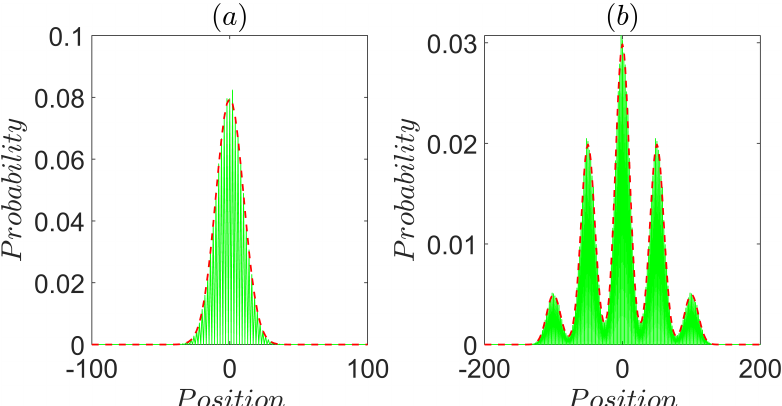
Figure 1. The simulated probability distributions of the one-dimensional Hadamard walk un- der the decoherence Model 1 for 100 time steps: ( a ) The walker is initiated from the local- ( | 0 (cid:105) + | 1 (cid:105) ) . The dashed line (red) shows the theoretical distribution. The ized state of | 0 (cid:105) ⊗ 1 √ 2 standard deviation (10.03) is propositional to the square root of time steps and exhibits the signature of a classical random walk. ( b ) The walker is initiated from a delocalized state of ∑ | x (cid:105) ⊗ ( α x | 0 (cid:105) + β x | 1 (cid:105) ) , where x ∈ {− 100, − 50,0,50,100 } and the corresponding ( α x , β x ) are x (cid:26) (cid:27) (cid:113) (cid:113) 3 3 ( 1 √ ) , ( 1 √ ) , ( ) , ( 1 √ ) , ( 1 √ ) , 1 √ , 1 √ , , 1 √ , 1 √ , respectively. The dashed line (red) 16 16 32 32 8 8 8 8 32 32 shows the theoretical distribution. The standard deviation (50.99) seems to indicate a non-diffusive behavior. The time step and the initial position states are even and hence the walker resides only on even sites after the 100 time